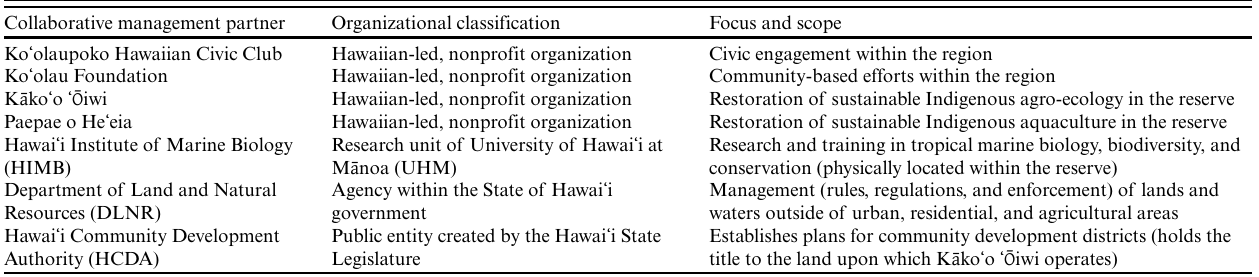
Table 1 . The seven collaborative management partners of the He ʻ eia National Estuarine Research Reserve and their respective organizational classifications. Each of these site partners holds a seat on the He ʻ eia NERR’s Advisory Board, and thus plays a role in the reserve’s